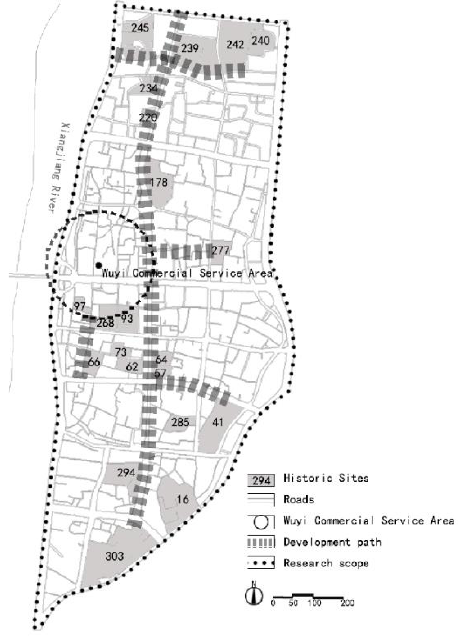
Figure 5. Current Land Use and Planning of the Transport Space Structure. Table 6. Centrality of Construction Land Plots used for Relics and Historic Site Conservation in 2021.